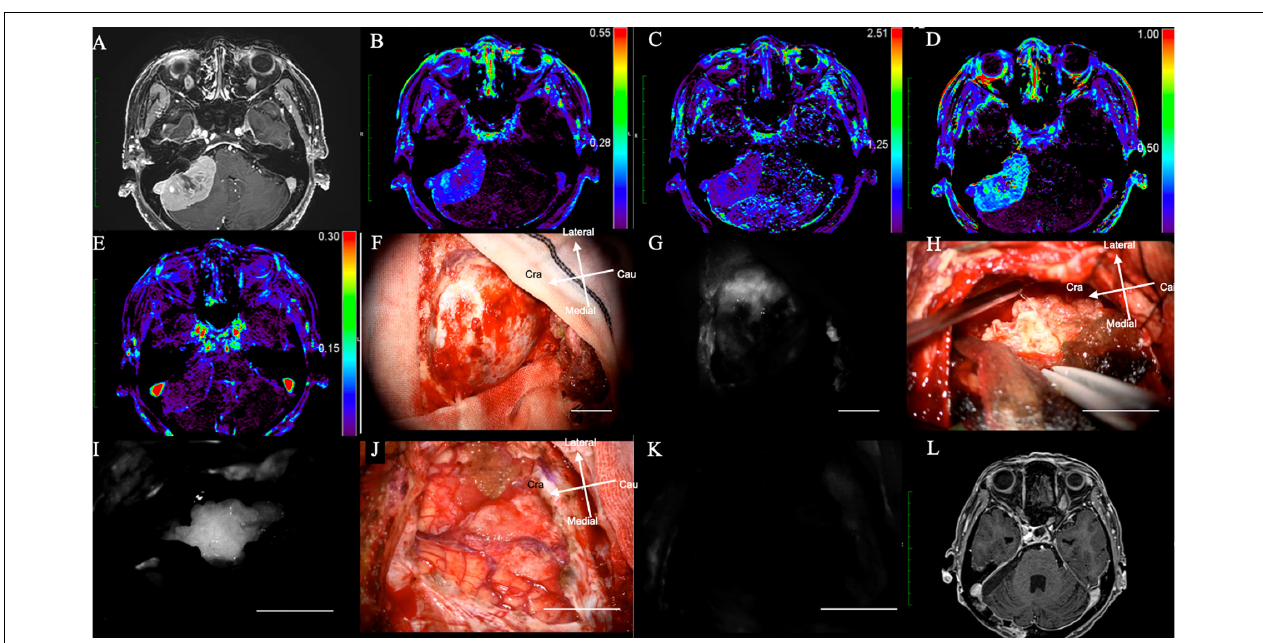
FIGURE 3 | (Case 14). Meningioma at the right cerebellopontine angle displaying NIR fluorescence by microscope using a KINEVO microscope. (A) Axial Gd-enhanced T1-weighted preoperative MRI showing the ring enhanced lesion in the right frontal lobe; (B) K trans , (C) K ep , (D) V e , and (E) V p on additional MRI. (F) Bright light image of the dura mater. (G) NIR fluorescence of the dura mater. (H) Tumor location during resection under bright light. (I) NIR fluorescence of the dura mater showing the exact tumor location with brain shift during tumor resection. (J) Bright light image. (K) No NIR fluorescence after tumor resection showing total removal of the tumor. (L) Axial Gd-enhanced T1-weighted postoperative MRI showing no residual lesion. NIR, near-infrared; Gd, gadolinium; MRI, magnetic resonance imaging; K trans , volume transfer constant; K ep , rate constant; V e , volume of the extravascular extracellular space; V p , vascular plasma